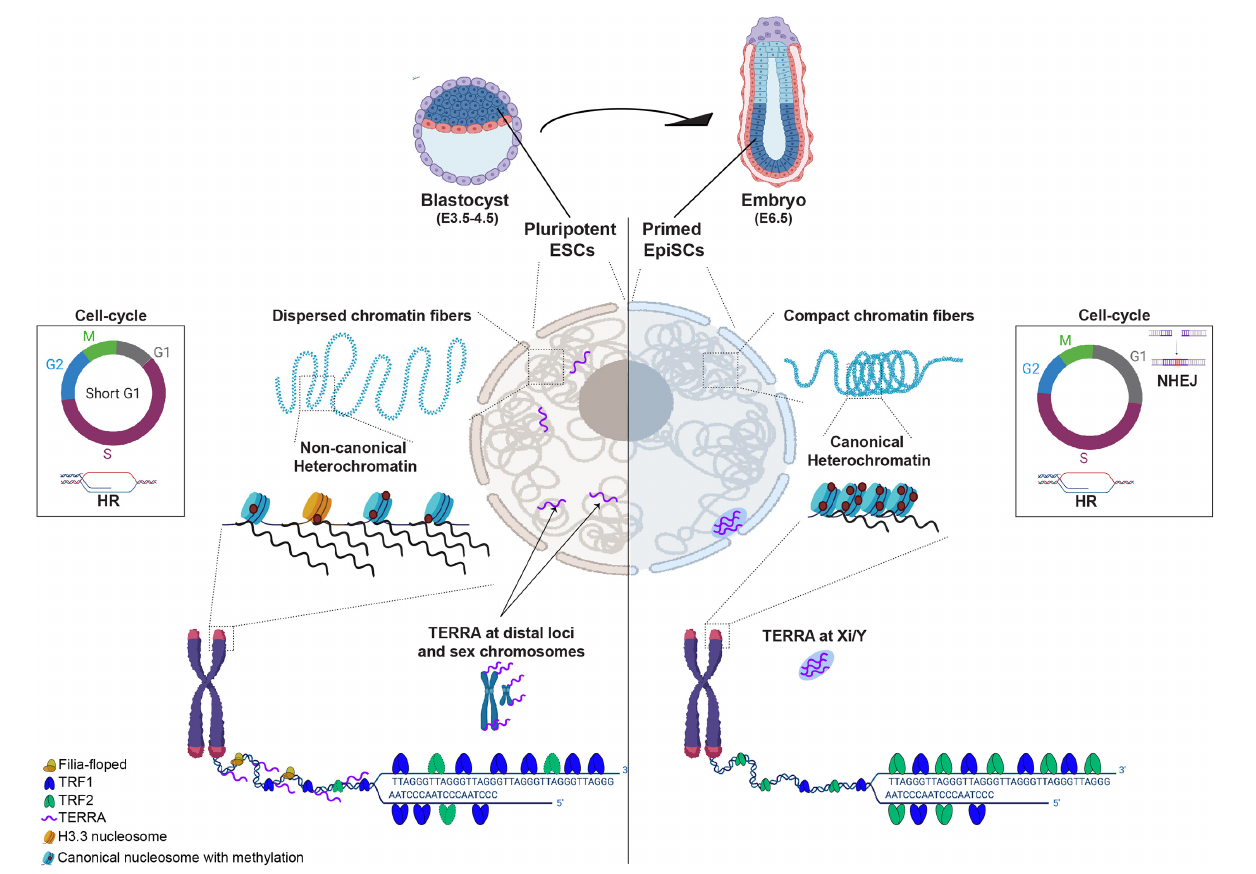
FIGURE 1 | Diagram schematizing differences between pluripotent (cells from blastocyst E3.5-4.5 or ESCs in culture) and cells that exited pluripotency and are primed to differentiate (epiblast at E6.5 embryos). In pluripotent ESCs (left nuclear panel), chromatin fibers are dispersed and heterochromatin is maintained in a non-canonical epigenetic state, characterized by low level of compaction and histone methylation, incorporation of histone H3.3 and high levels of transcription. TRF1, a core shelterin component is highly expressed and TRF2, although present, is not required for telomere protection in ESCs. Filia-floped complexes are recruited to telomeres to mitigate stalled replication forks and telomere transcripts (TERRA) locate at sex chromosomes but also at other distal genomic loci. ESCs have a short G1 phase of the cell-cycle, favoring the use of homologous recombination (HR) to repair DNA damage. In cells that exited pluripotency (in Epiblast of E6.5), chromatin fibers become more dense and heterochromatin adopts a canonical state, characterized by high levels of histone methylation, compaction and transcription silencing. At telomeres, TRF2 becomes crucial for telomere protection and TERRA levels are reduced and redistributed to the inactive sex